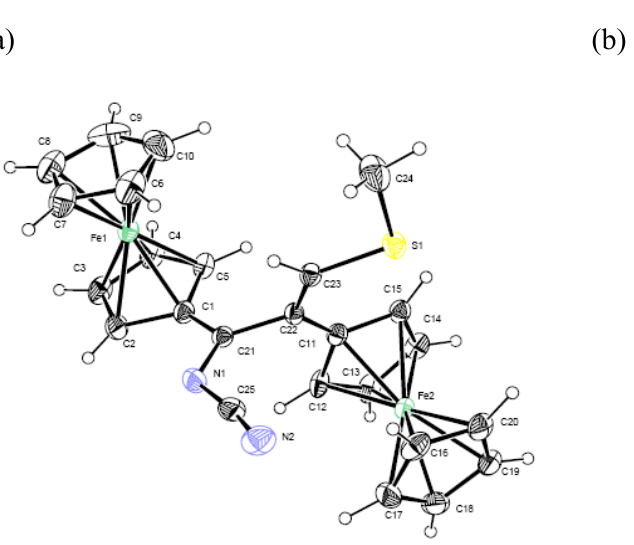
Figure 3. (a) Crystal structure of 10 ; (b) Crystal packing of